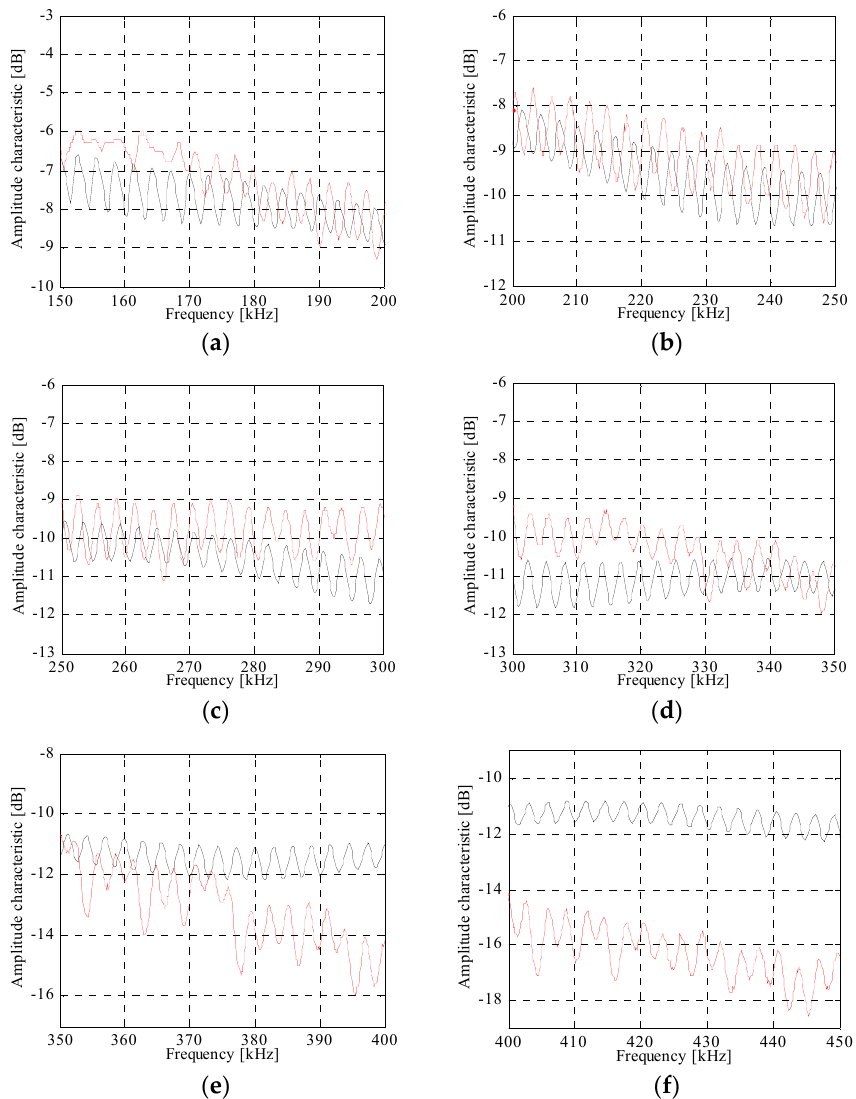
Figure 7. Comparison of the simulated amplitude characteristic of the 400 kV PLC channel with the measured for different frequency intervals ( a – f ): black-simulated, red-measured.